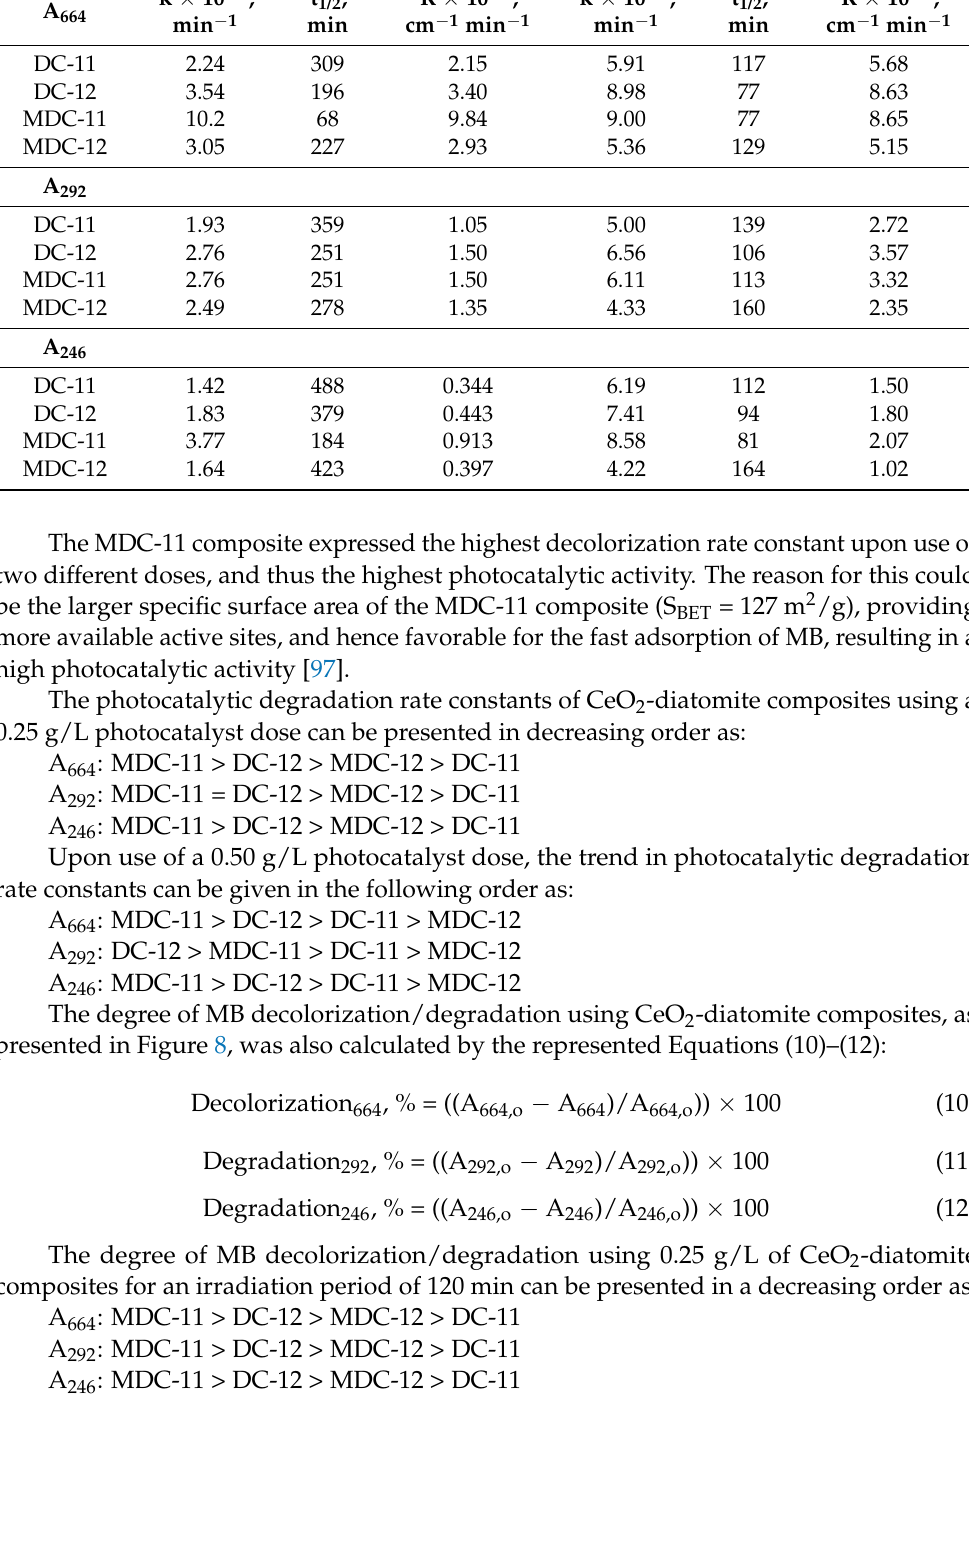
Table 2. Photocatalytic degradation kinetics of MB expressed by A 664 , A 292 , and A 246 . First-Order Kinetic Parameters First-Order Kinetic Parameters Dose: 0.25 g/L Dose: 0.50